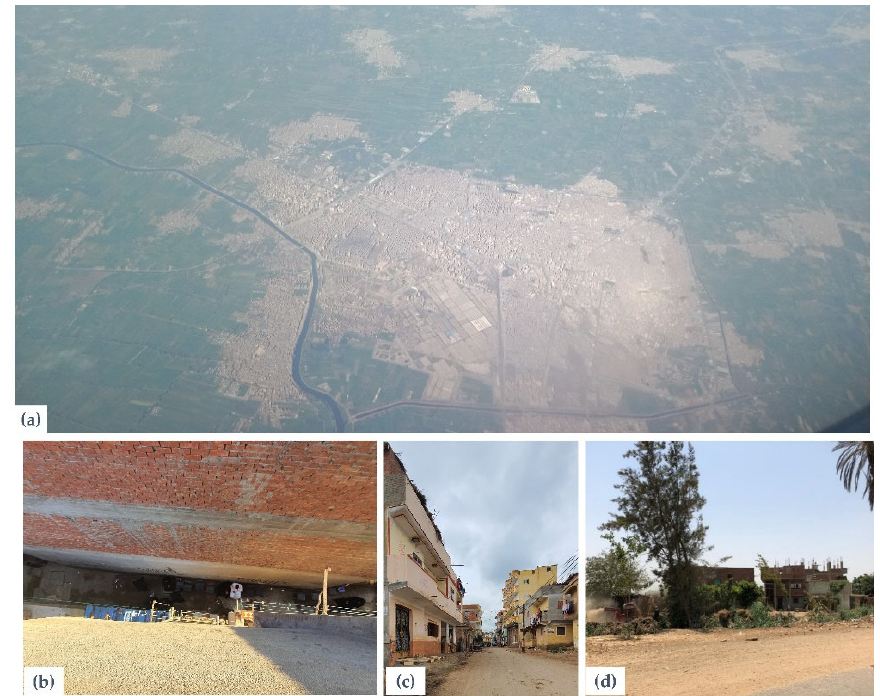
Figure 6. Some urban characteristics of typical Egyptian rural settlements in the Delta region (images taken by Ahmed Abouiana). ( a ) Aerial view of a typical urban fabric of Almahalla Alkobra District, Gharbia Governorate, Delta Region. It depicts the administrative hierarchy from the city towards districts, main villages, and dependents’ villages within the ecosystems. ( b ) A typical traditional tissue, Lasaifar Albalad (the preliminary stage of the village’s growth). The 2m-width close-end path hosts social events (e.g., funerals); ( c ) Typical linear pattern, Lasifar Albalad settlement (the second growth phase, surrounds the old center); ( d ) Typical scattered pattern, Menouf, Gharbia Governorate. It spreads in marginal parts outside the inhabited centers and encroachment over agrarian land until 2019; the government has prevented this by intensive penalties (Law No. 164 of